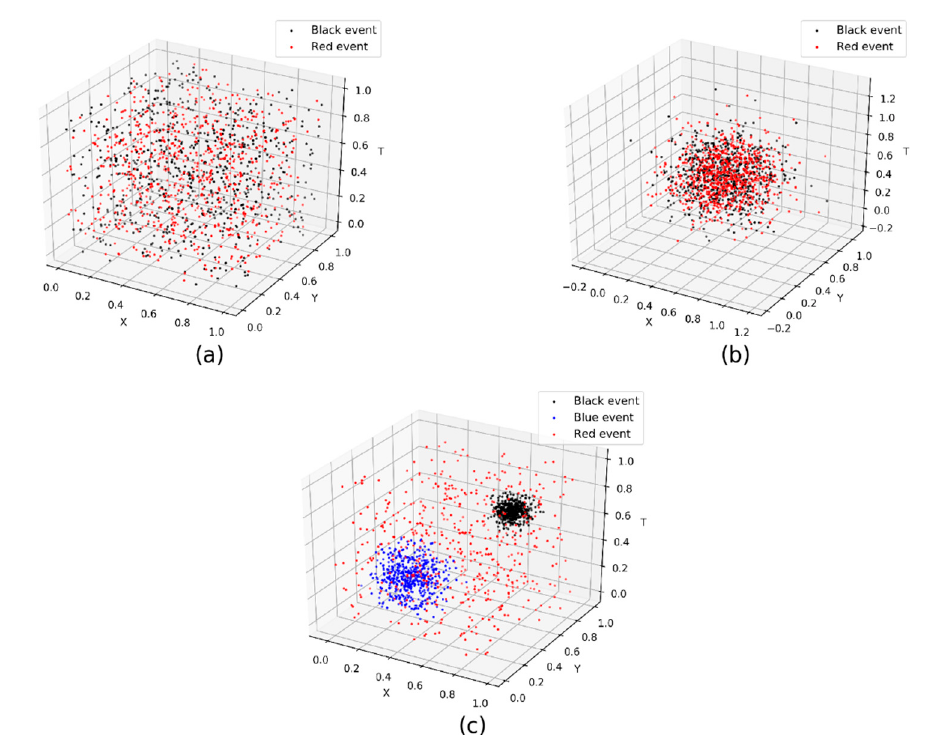
Figure 2. Examples of simulated data in ( a ) group 1, ( b ) group 2, and ( c ) group 3.